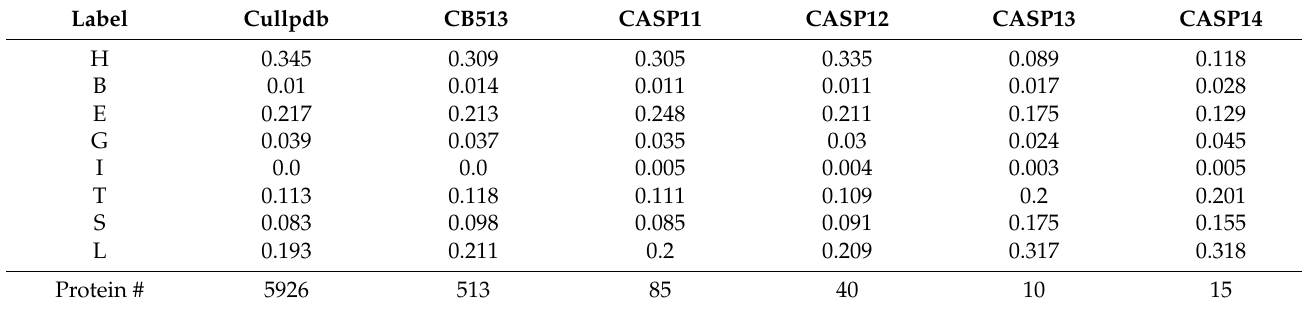
Table 1. The percentage of each secondary structure type and protein number on the training and test